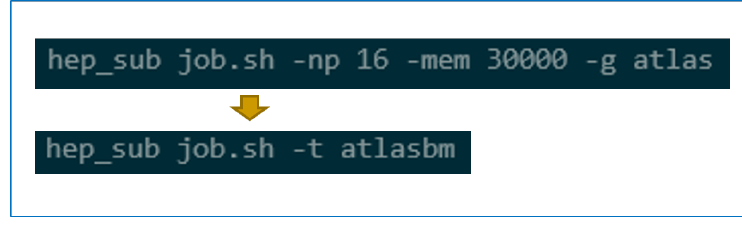
Figure 4: Template Usage